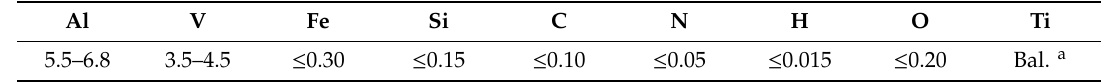
Table 1. Chemical compositions (wt.%) in the Ti-6Al-4V metal.